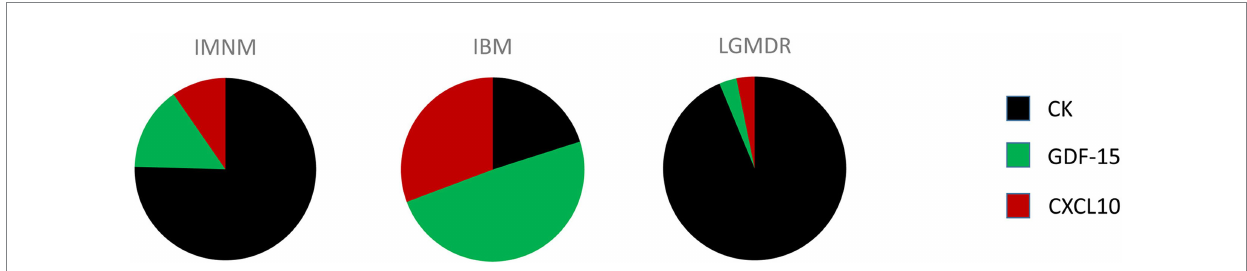
FIGURE 1 Comprehensive quantitative representation of the relative importance of creatine kinase (CK), growth differentiation factor 15 (GDF-15), and C-X-C motif chemokine 10 (CXCL10) serum levels in patients diagnosed with immune-mediated necrotizing myopathy (IMNM), sporadic inclusion body myositis (IBM) and limb girdle muscular dystrophy recessively inherited (LGMDR) patients diagnosed with LGMDR12 ANO5 and LGMDR25 POPDC1